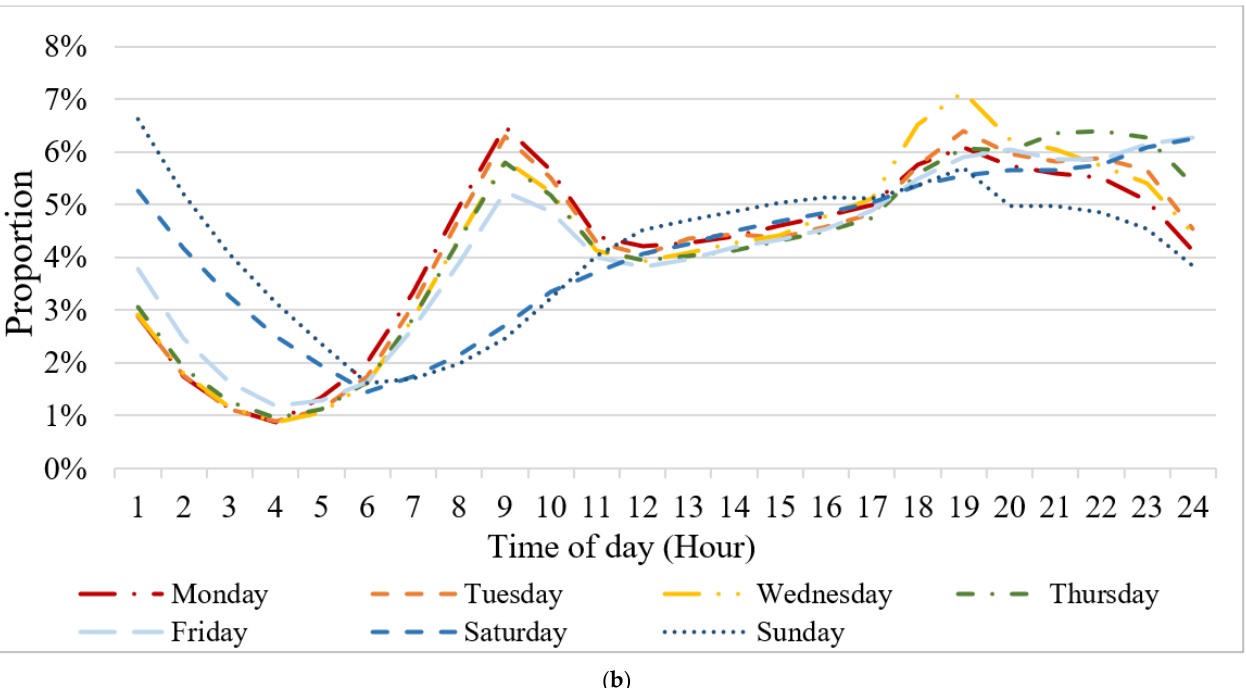
Figure 7. Hourly OD distribution from Monday through Sunday. ( a ) Shenzhen City. ( b ) New York City.